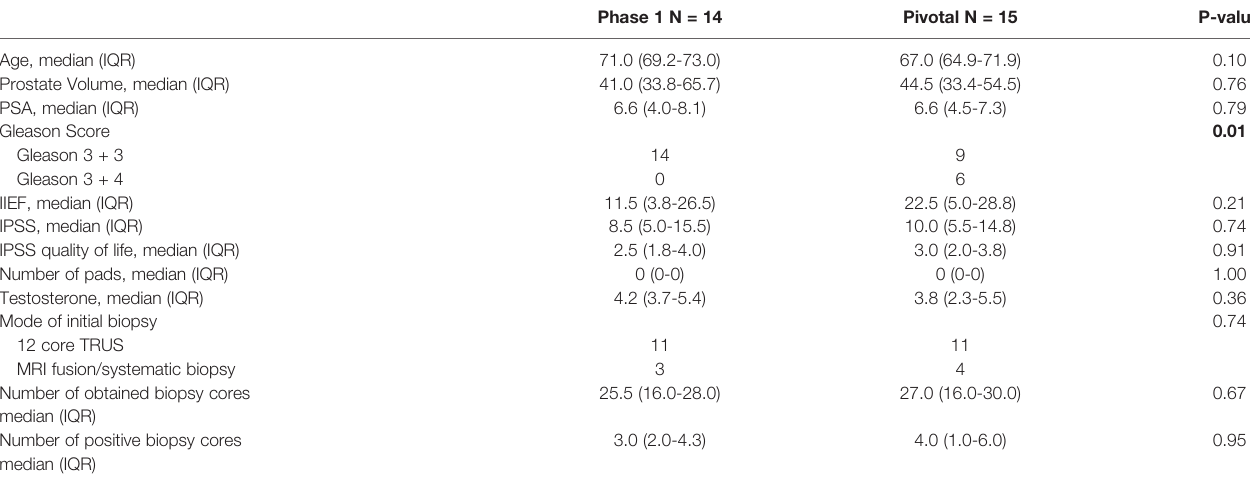
TABLE 1 | Clinical baseline and pathological characteristics between the Phase I and pivotal trial patients treated at our institution.